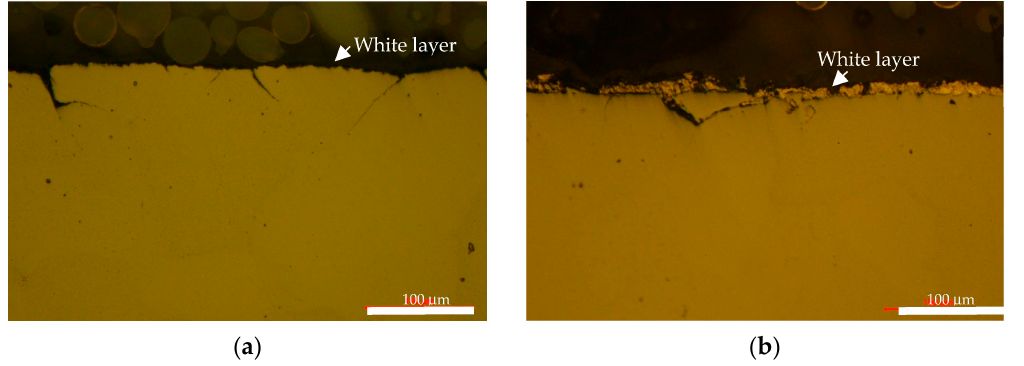
Figure 10 . SEM photographs of white layer . ( a ) USV - WEDM; ( b ) WEDM .